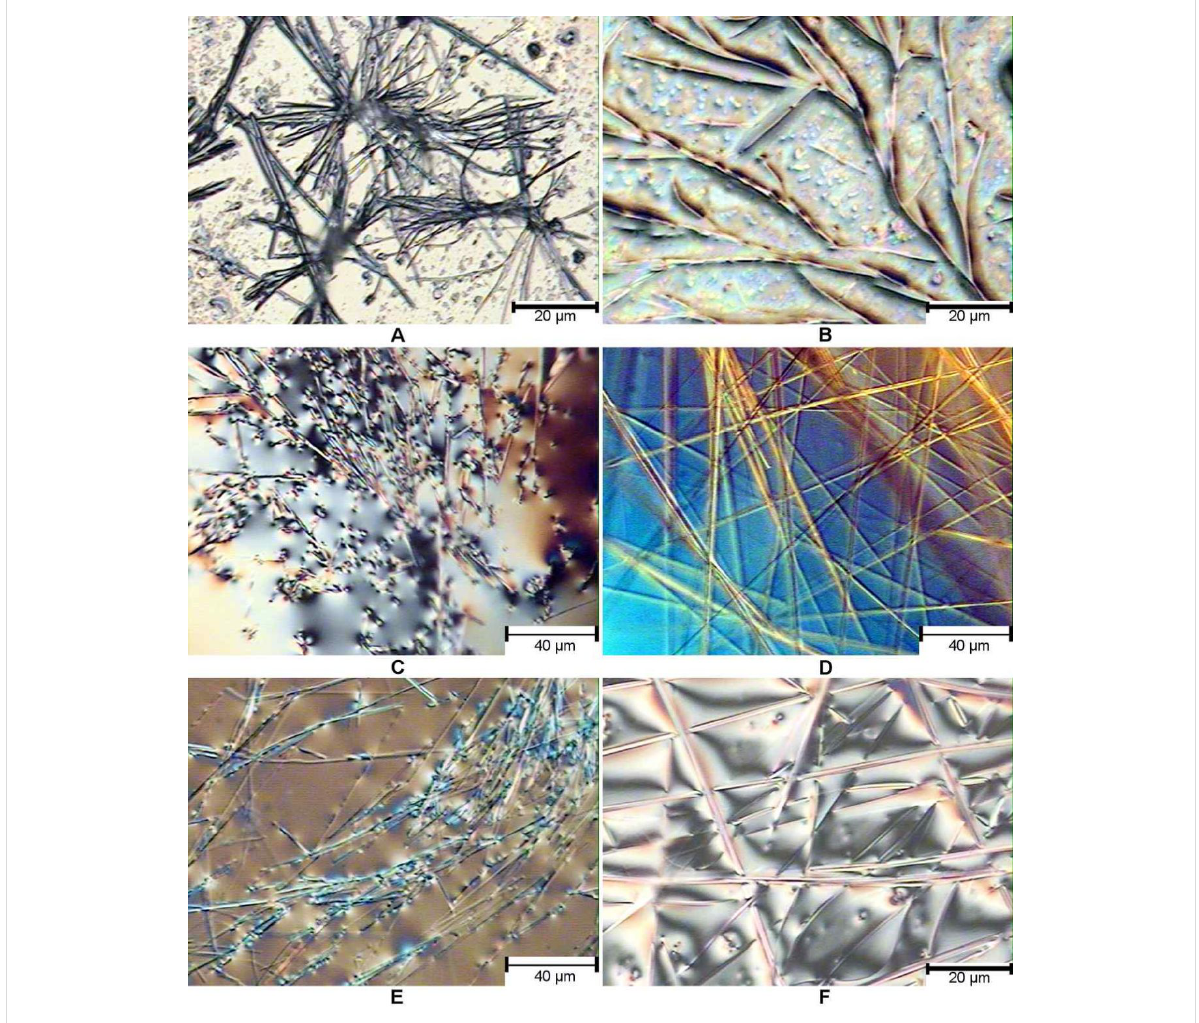
Figure 3: Optical micrographs of the gels formed by compound 9A in hexane at 15 mg/mL ( A , B ), 9B in DMSO/water (1:2) at 20 mg/mL ( C , D ), and 15B in EtOH/H 2 O (1:2) at 4 mg/mL ( E , F ). The images were taken with gels containing solvents (not dried